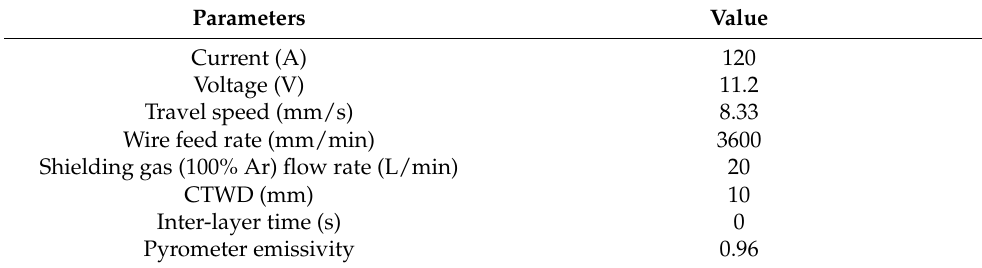
Table 2. Process parameters for CMT-WAAM.